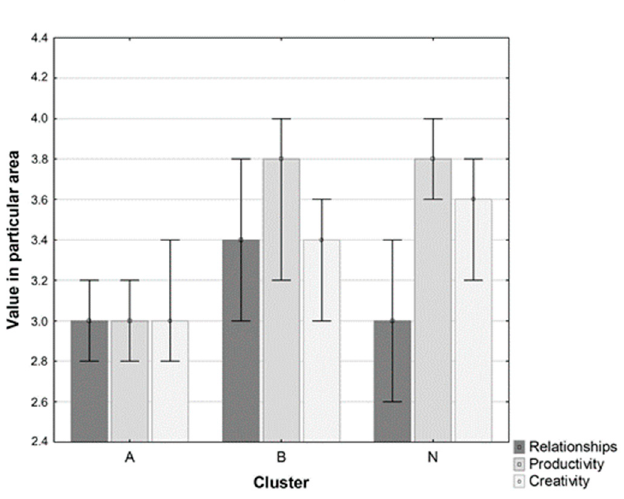
Figure 3. Values (mean) in the analyzed three areas (relationship, productivity, and creativity) in identified clusters. Median (bars) and interquartile range (whiskers) are presented on the graph.